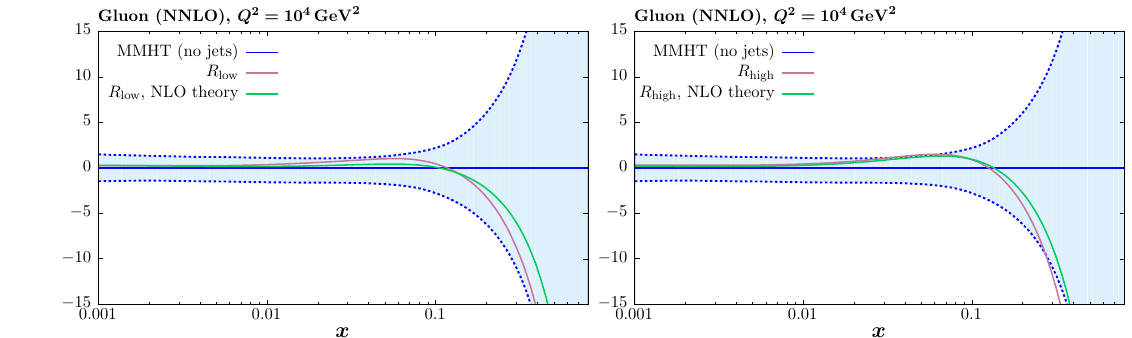
Fig. 10 The impact on the gluon PDF at NNLO of the ATLAS [23] and CMS [24] 7 TeV jet data. The percentage difference in comparison to the baseline fit, with no jet data included, is shown. Results are shown